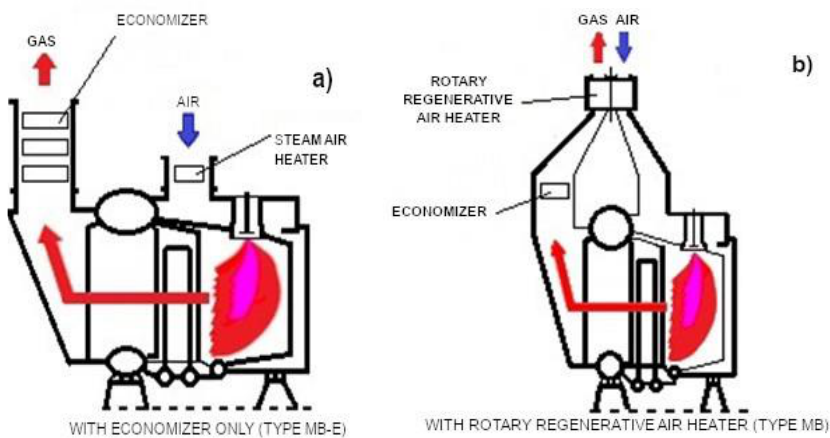
Figure 2. Options of waste heat utilization for MB boiler of Mitsubishi: ( a ) multistage water heater, ( b ) water and air heater [4,6].